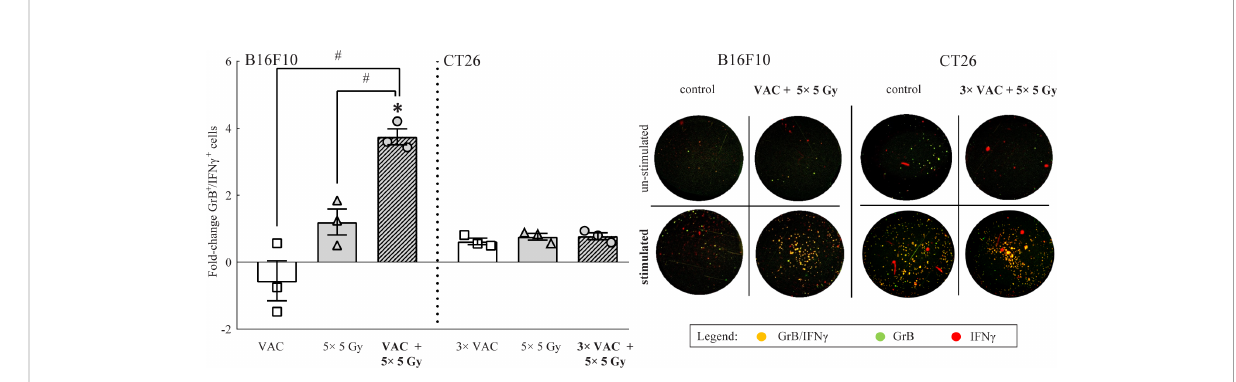
FIGURE 4 FluoroSpot analysis of tumor speci fi c GrB+/ IFN g + immune cells from lymph nodes on day 6. The amount of tumor speci fi c GrB+/ IFN g + immune cells from lymph nodes of both tumor-type bearing mice. Representative images of FluoroSpot wells for both tumor models is shown on the right side of the graph. The orange/yellow spots represent double positive immune cells. Legend: fold-change relative to the absolute number of stimulated tumor speci fi c GrB+/ IFN g + immune cells of the control group; *p < 0.05 versus the control group; # p < 0.05 between the annotated treatment groups: VAC = selected concomitant single- and multi-dose vaccinations for B16F10 and CT26 tumor models, respectively; IR = selected 5 × 5 Gy IR